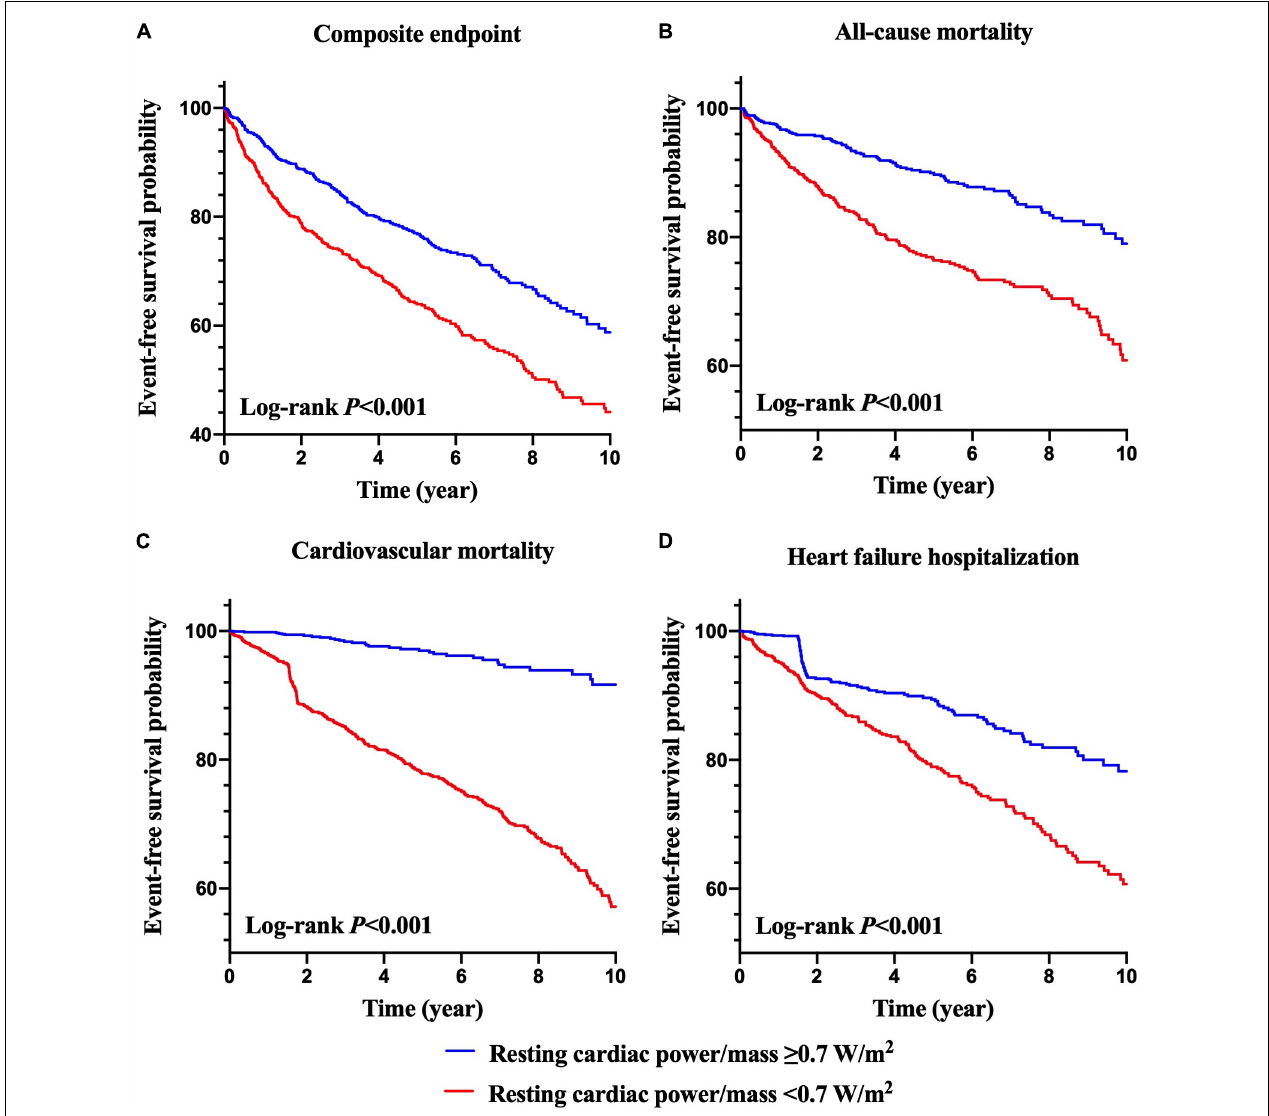
FIGURE 1 | Kaplan–Meier survival curves for prediction of composite endpoint (A) , all-cause mortality (B) , cardiovascular mortality (C) and heart failure hospitalization (D) in patients with higher resting cardiac power/mass ( ≥ 0.7 W/m 2 ) and lower resting cardiac power/mass ( < 0.7 W/m 2